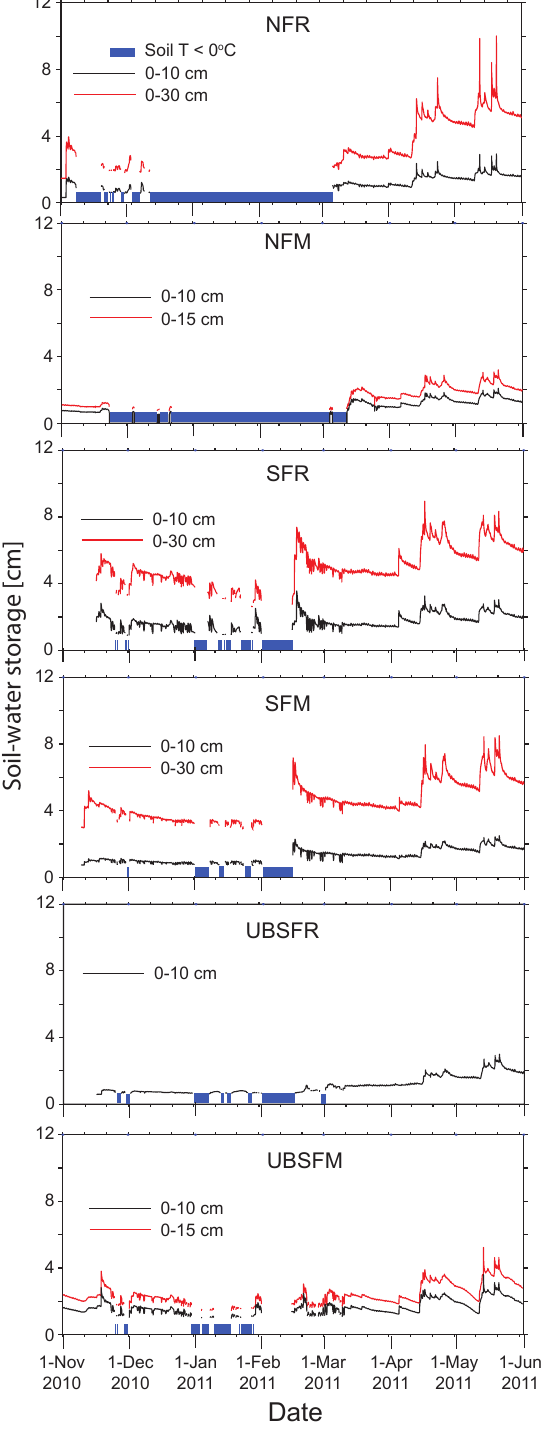
Fig. 9. Soil-water storage during the snowmelt season based on trapezoidal integration of the depth profiles from the Decagon 5TE sensors. Storage estimates are not calculated when soil temperature is below 0 ◦ C, which is shown by dark blue